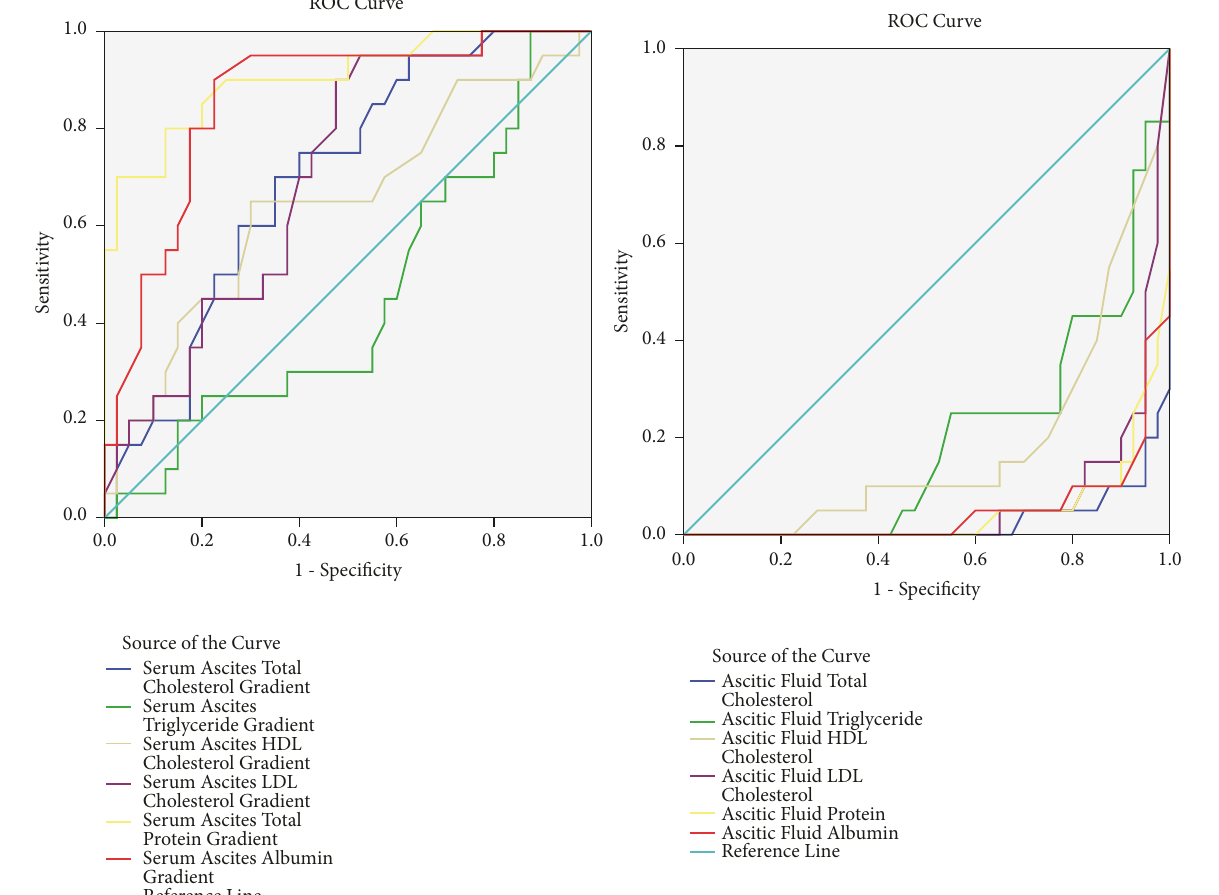
Figure 2: ROC curve analysis between cirrhotic vs. noncirrhotic